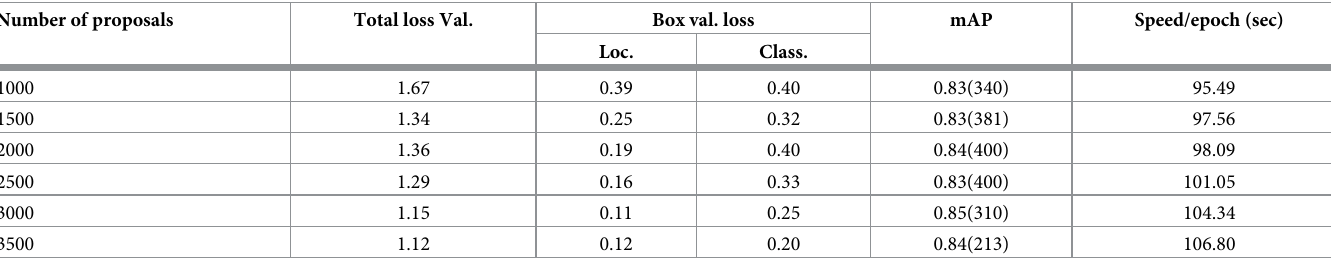
Total loss for validation, box-validation loss for localization (Loc.) and classification (Class.), best mAP until 400 steps, and training time for one epoch in seconds using between 1,000 and 3,500 proposals. Increasing the number of proposals decreased the box validation loss and, consequently, improved the